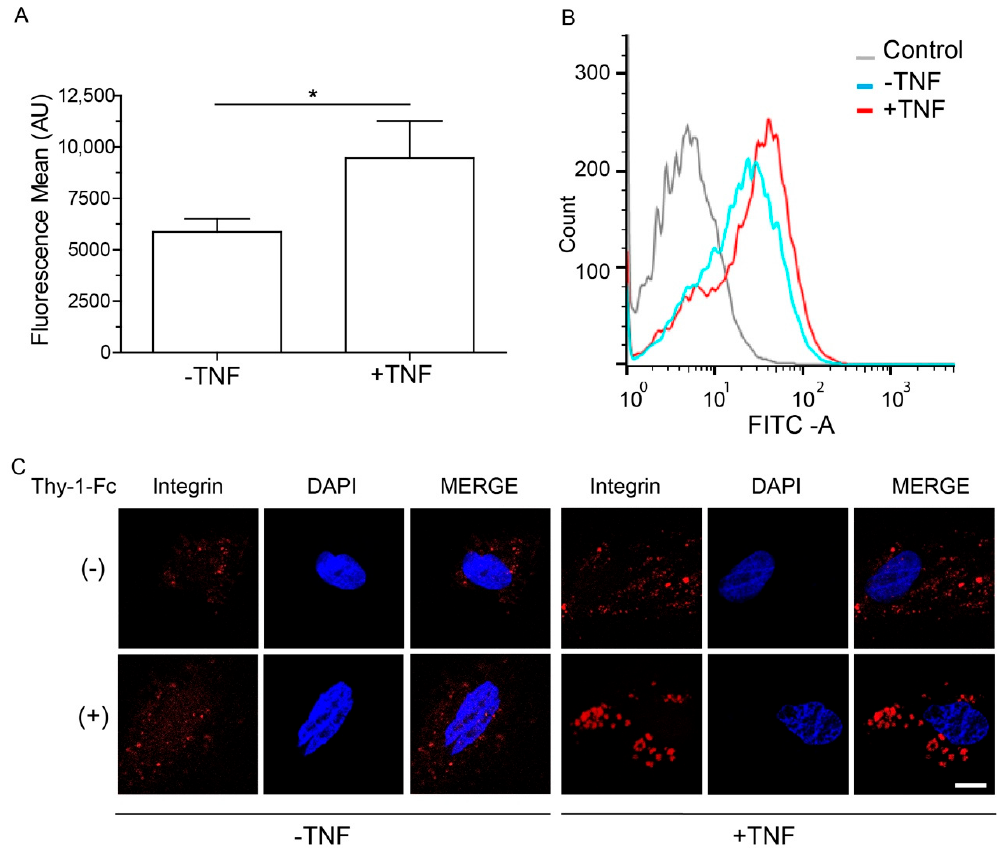
Figure 2. Expression levels of β 3 integrin increase at the cell surface and form β 3 integrin receptor clusters. ( A ) Analysis of β 3 integrin abundance at the cell surface by flow cytometry (FACS) analysis